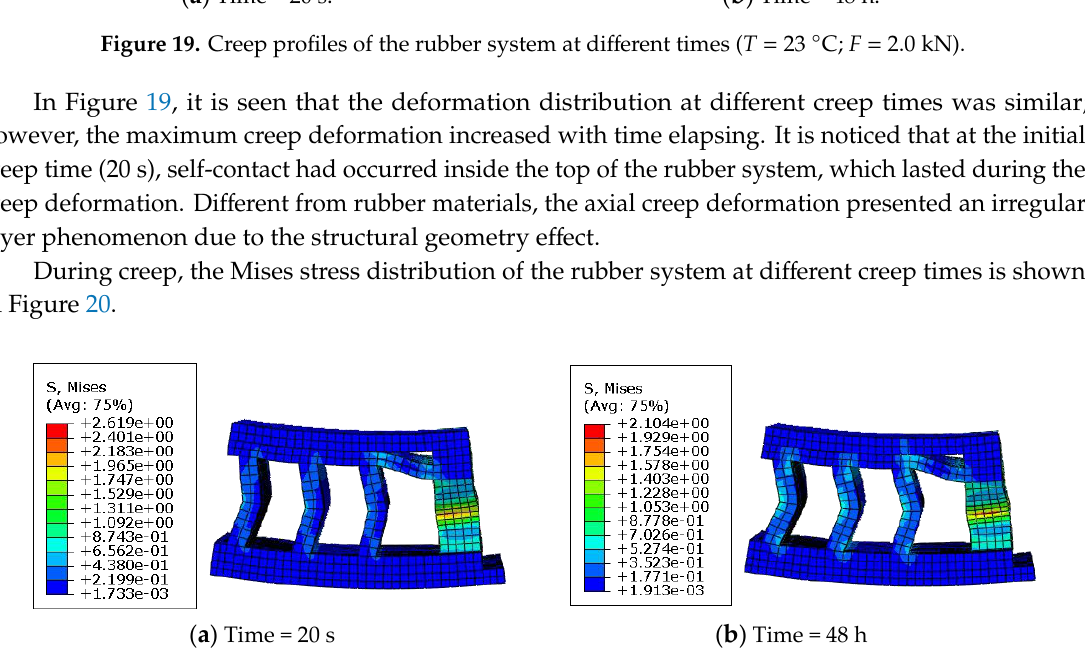
Figure 20. Mises stress distribution of the rubber system at different creep times ( T = 23 °C; F = 2.0 kN).